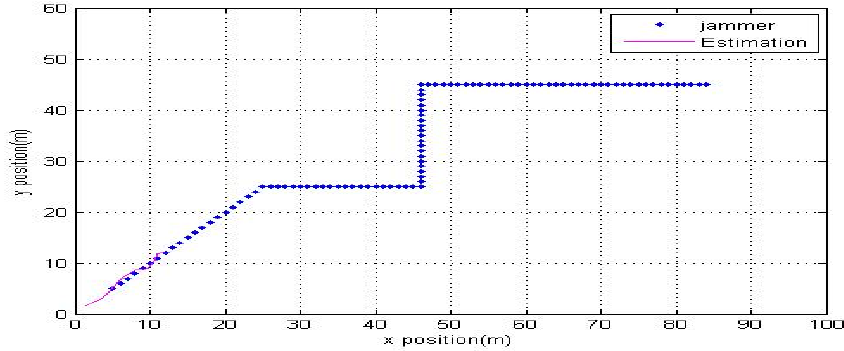
Figure 6. EKF output. The system stops tracking at t = 11 s.